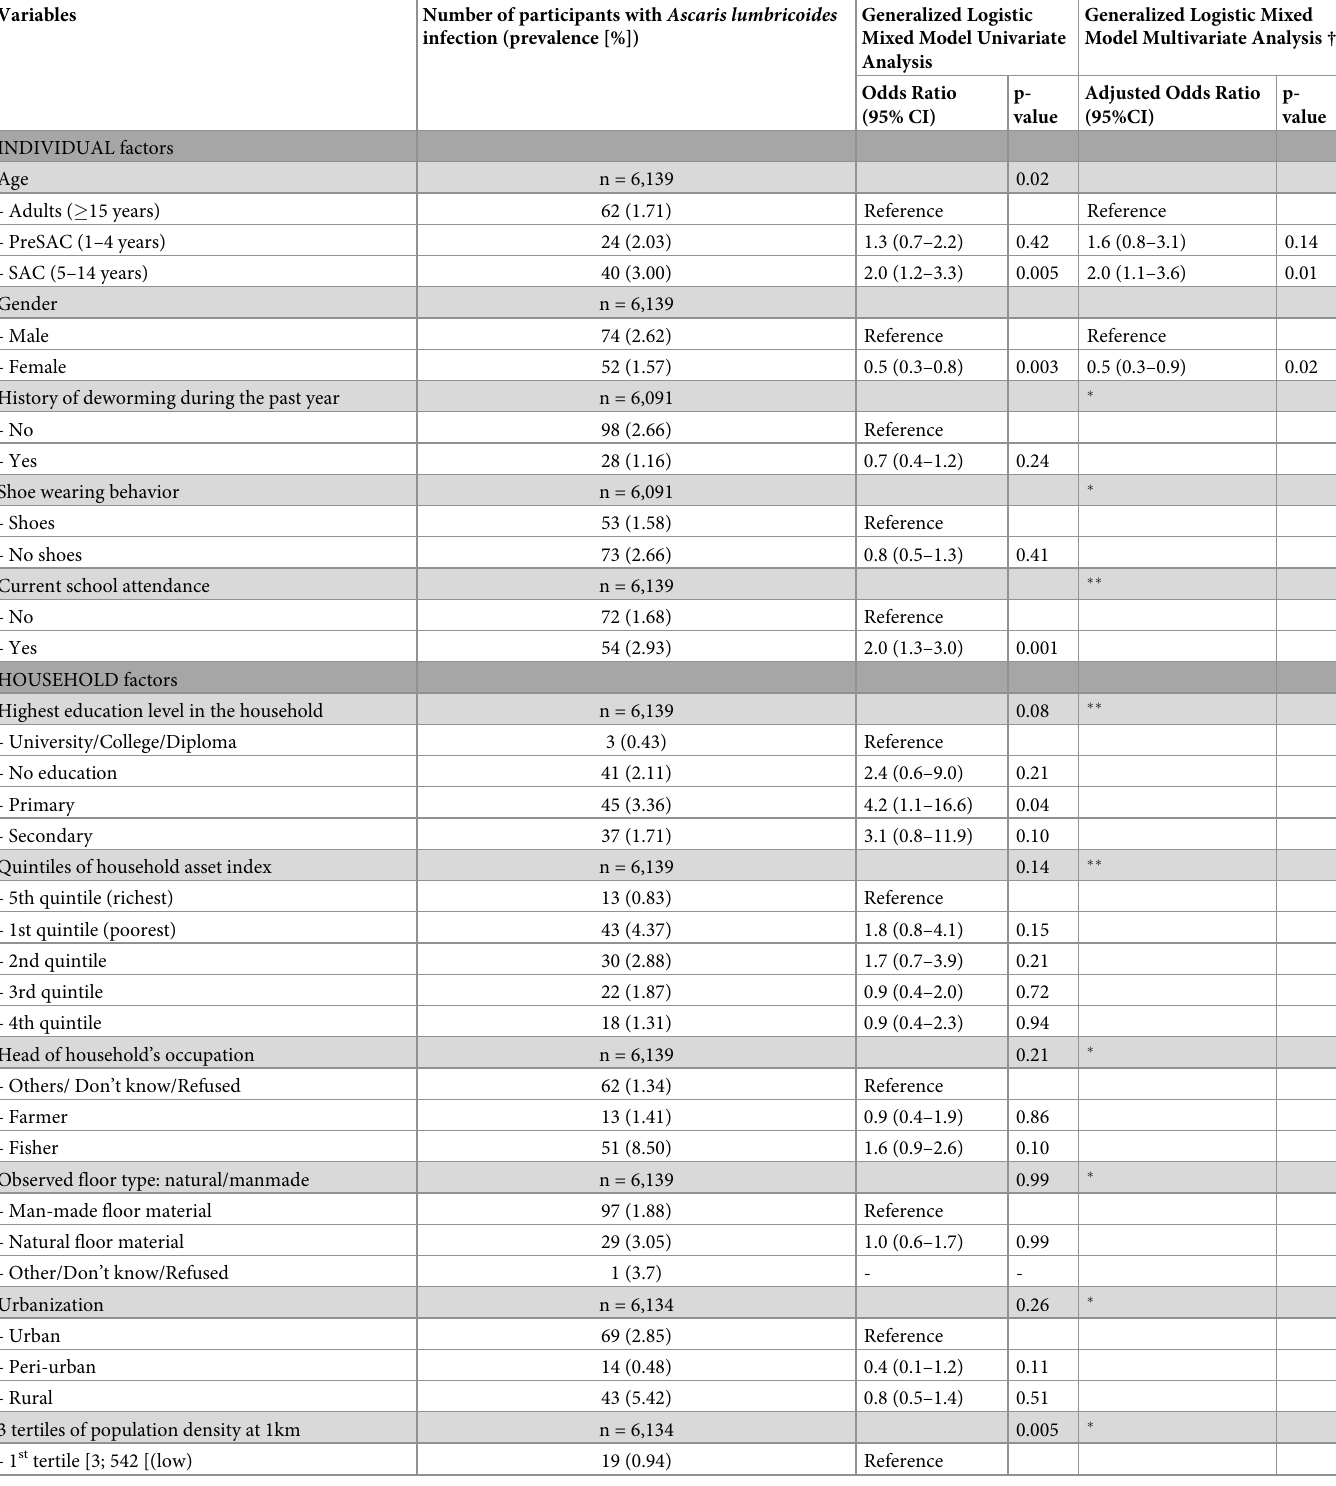
Table 4. Factors associated with the prevalence of Ascaris lumbricoides infection in Come´, Be´nin: findings from a baseline prevalence survey using Kato-Katz